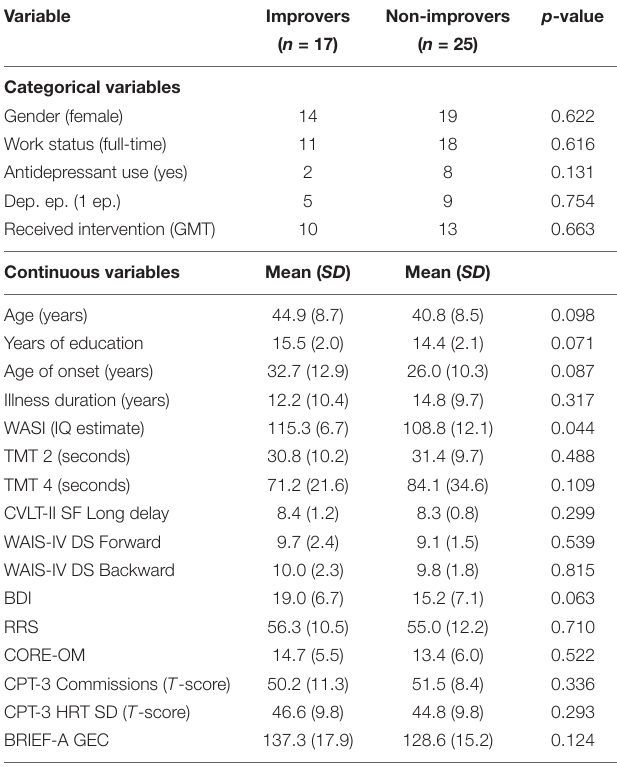
TABLE 2 | Comorbid ICD-10 diagnoses in the completer sample. Disorder Frequency Generalized anxiety disorder (F 41.1)